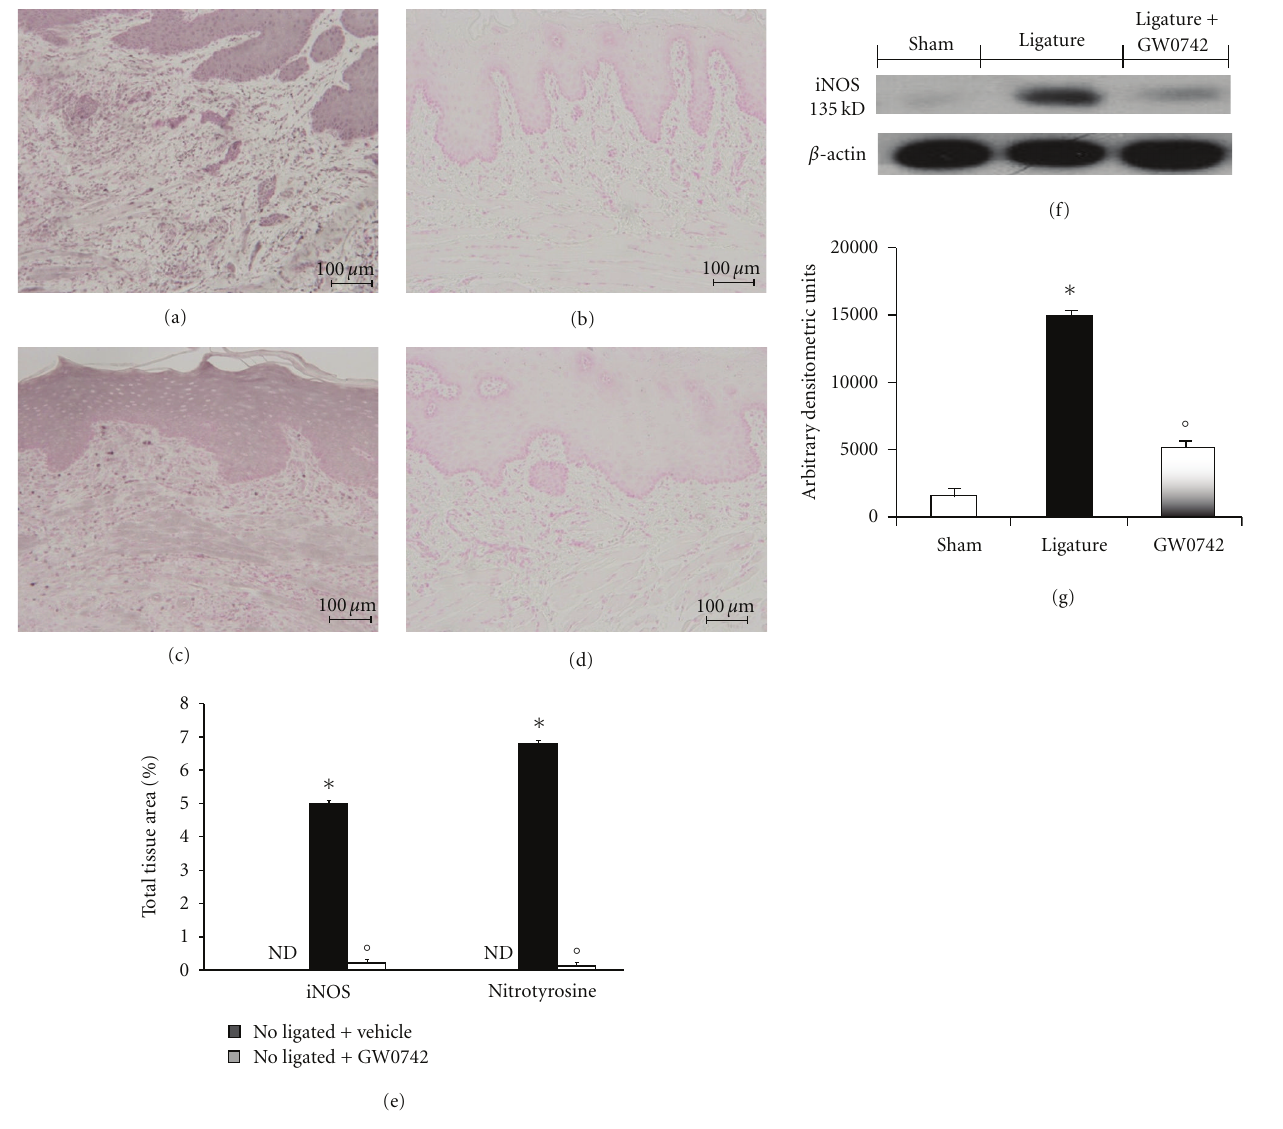
Figure 4: E ff ect of GW0742 on iNOS expression. Positive staining for iNOS (a) and nitrotyrosine (c) was observed in gingivomucosal tissue after ligature. In gingivomucosal tissue of GW0742-treated rats, no positive staining was observed for iNOS (b) and nitrotyrosine (d). Densitometry analysis of immunocytochemistry photographs ( n = 5 photos from each sample collected from all mice in each experimental group) for iNOS and nitrotyrosine was assessed (e). Moreover a significant increase in iNOS expression, assayed by western blot analysis, was detected in the tissue from ligature-treated rats (f, g). The treatment with GW0742 significantly reduced iNOS expression (f, g). This figure is representative of at least 3 experiments performed on di ff erent experimental days. A representative blot of lysates obtained from 5 animals per group is shown, and densitometry analysis of all animals is reported. The results in (g) are expressed as mean ± S.E.M. from n = 5 / 6 gingivomucosal tissues for each group. ∗ P < 0 . 01 versus nonligated group. ◦ P < 0 . 01 versus ligated group.